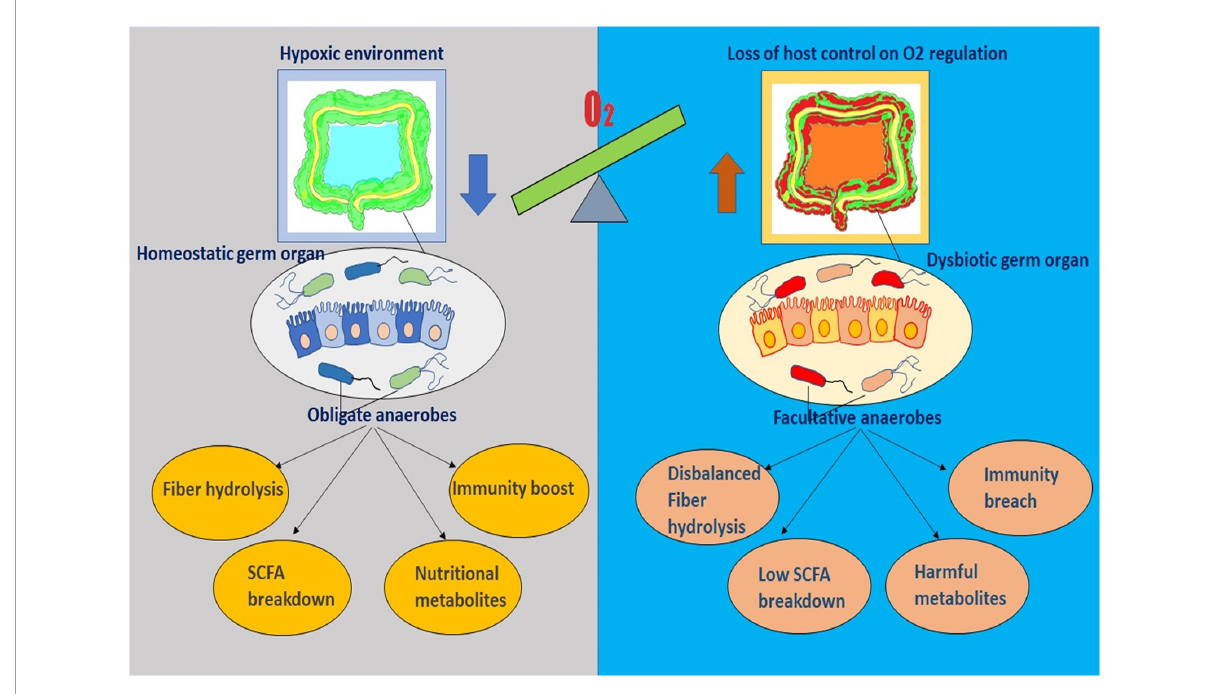
FIGURE2 The diagram represents the sensitive interplay existing between the gut microenvironment and the residing microflora. It outlines the key role of oxygen imbalance in dysbiosis and diseased